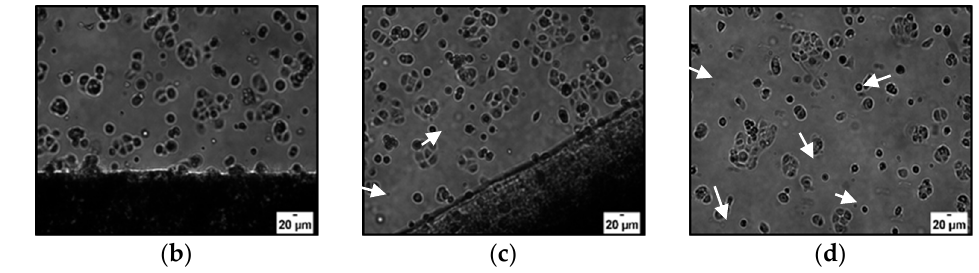
Figure 9. Microscope images of SCC-25 cells 24 h after incubation with ( a ) H ALG-GO , ( b ) CUR@H ALG-GO 2.5%, ( c ) CUR@H ALG-GO 5.0%, and ( d ) CUR@H ALG-GO 7.5%. Arrows indicate apoptotic cells.